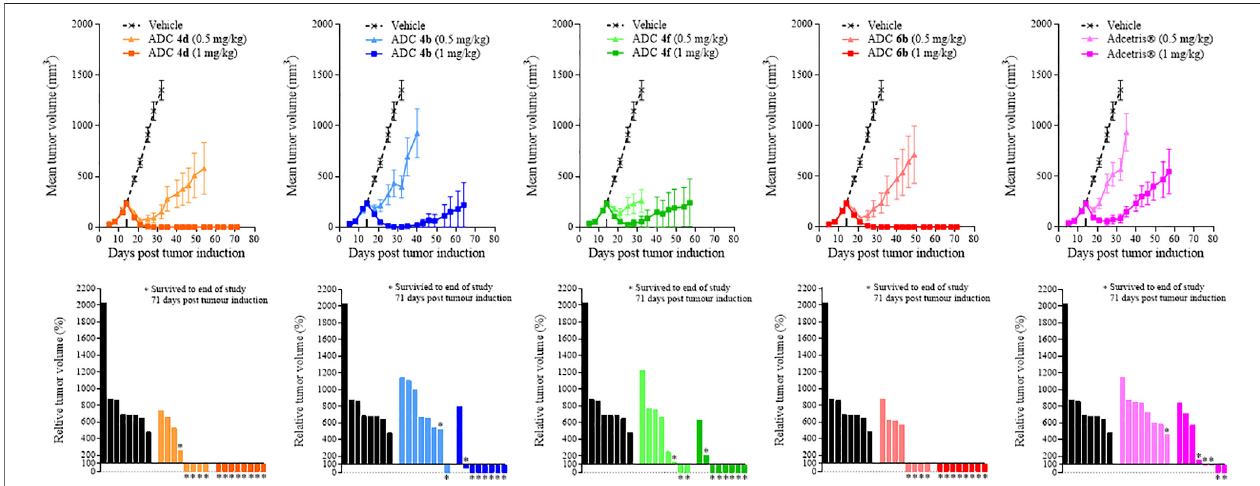
FIGURE 2 | Tumor growth curves and relative tumor volume (%) plots taken on the fi nal day of the study (Day 71) for xenograft study 1. Mean tumor volume was plotted untilthe fi rst death inthe group wasrecorded. Relative tumor volumes were calculated as percentage change on the fi nal day ofthe study(Day 71) relative tothe tumor volume on the day of treatment administration (Day